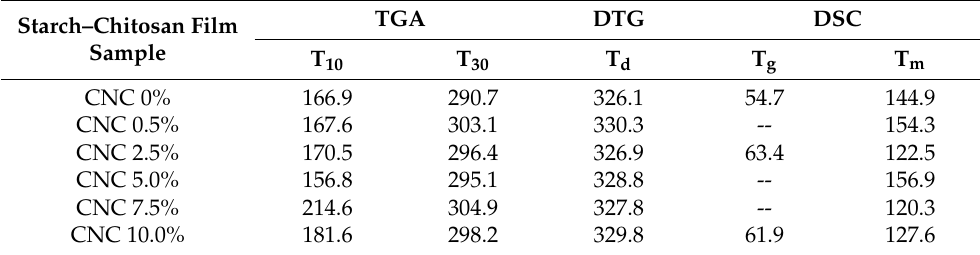
Table 2. Temperature data (expressed in ◦ C) related to thermal analysis of nanocomposite films incorporated with CNC (0 to 10% w / w ). Starch–Chitosan